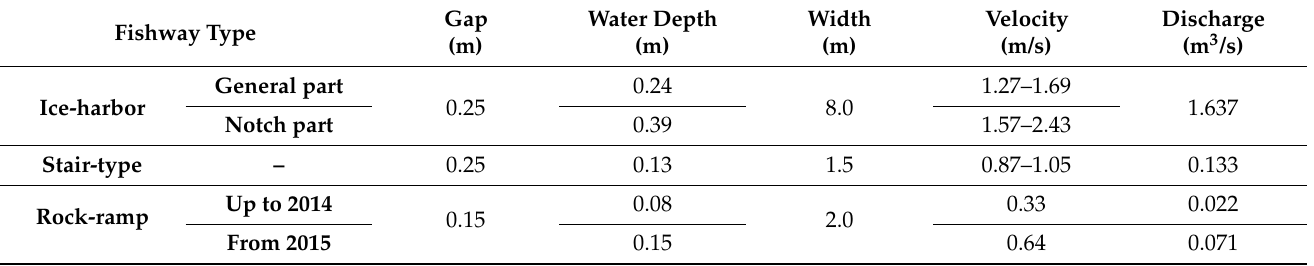
Table 3. Fishway specifications. Three fishways with different water depths and flow velocities were constructed at Miyanaka Intake Dam. The width details are shown in Figure 2c,d.